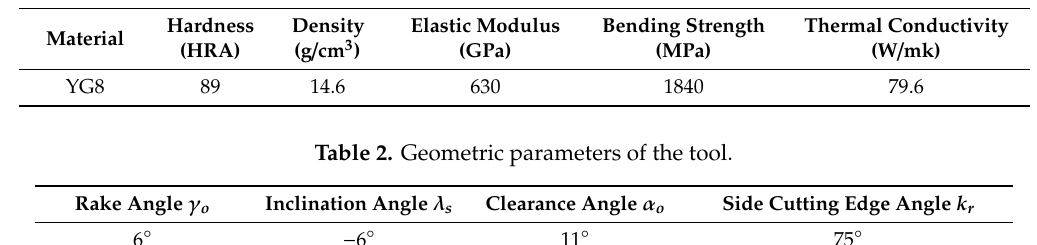
Table 1. Physical characteristics of the YG8 material.